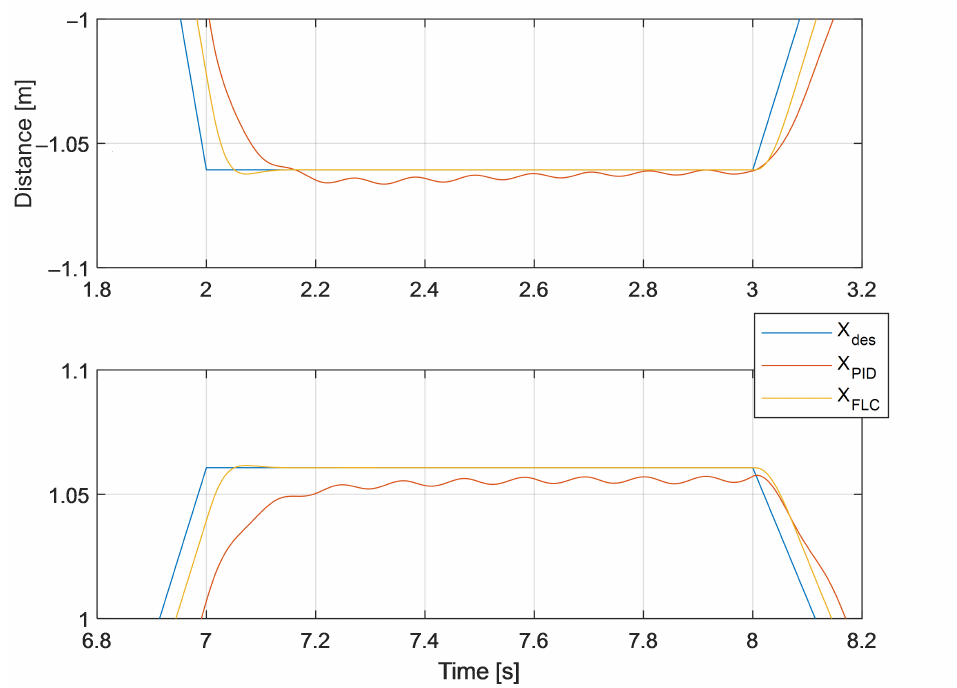
Figure 10. Zoom in a “steady-state”